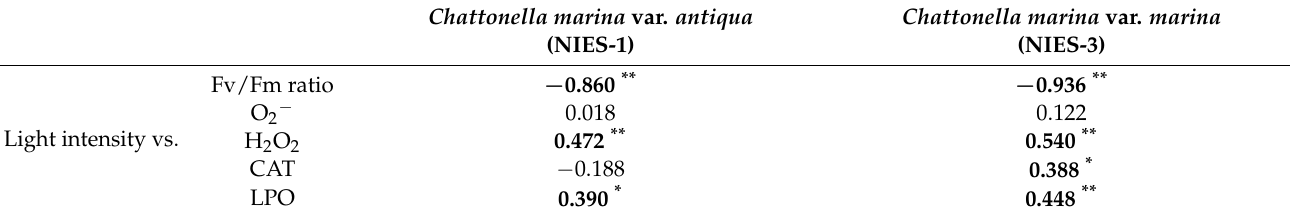
Pearson correlation coefficients between light intensity and Fv/Fm ratio, O 2 − concentration (O 2 − , chemiluminescence cell − 1 ), H 2 O 2 concentration (H 2 O 2 , pmol cell − 1 ), H 2 O 2 scavenging activity (CAT activity equivalence, unit cell − 1 ), and LPO concentration (LPO, pmol cell − 1 ). ** , p < 0.01; * , p < 0.05. Chattonella marina var.